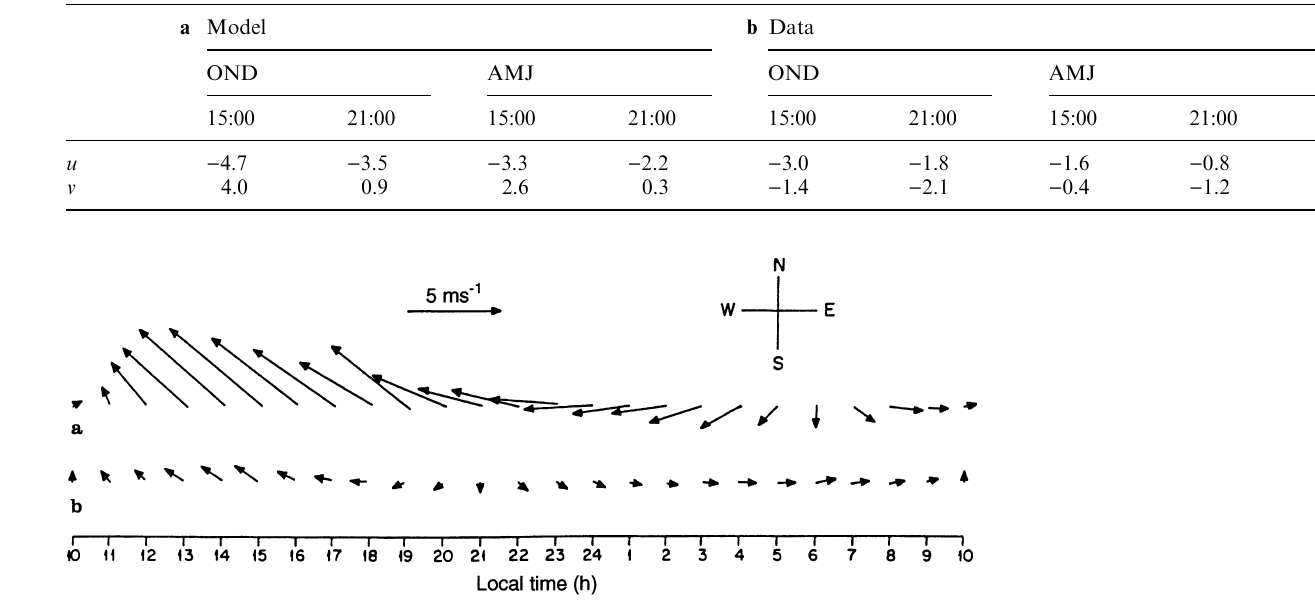
Table 4. Values of u and v -components of the horizontal wind at 15:00 LT and 21:00 LT for OND and AMJ: a simulated at a gridpoint inland situated 10 km from both the SN and EW coastlines (point E in Fig. 1) at the level of 990 hPa; b observed